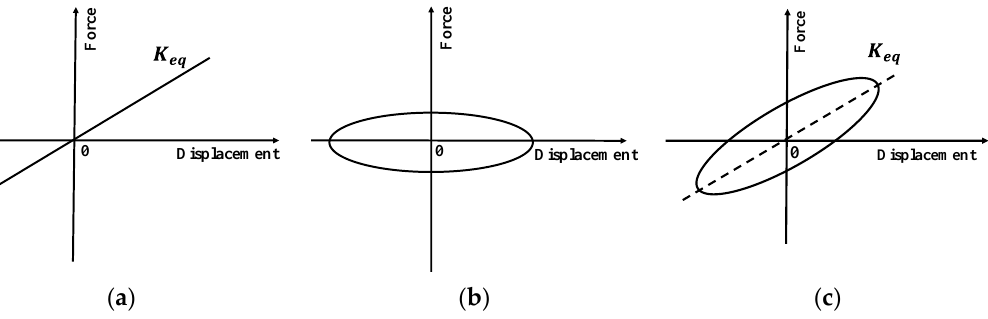
Figure 3. Horizontal force-displacement hysteresis model of: ( a ) A bearing, ( b ) a damper, ( c ) the combination of a bearing and damper.